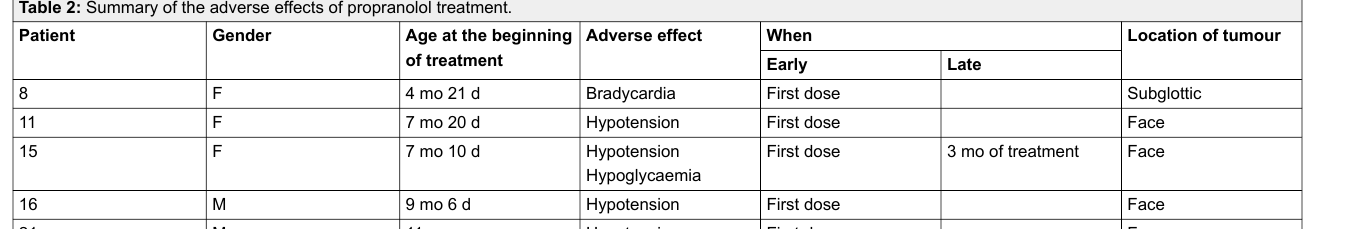
Table 2: Summary of the adverse effects of propranolol